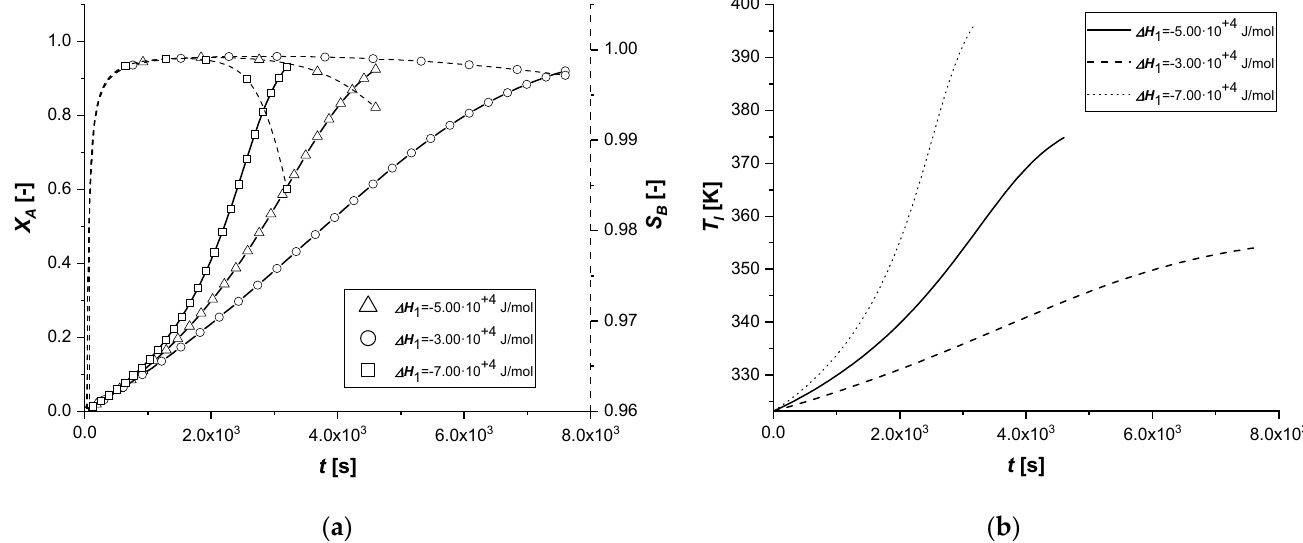
Figure 5. ES ∆ rH 1 investigation. ( a ) Bulk profiles over time of X A and S B . ( b ) Bulk profile of T l over time.